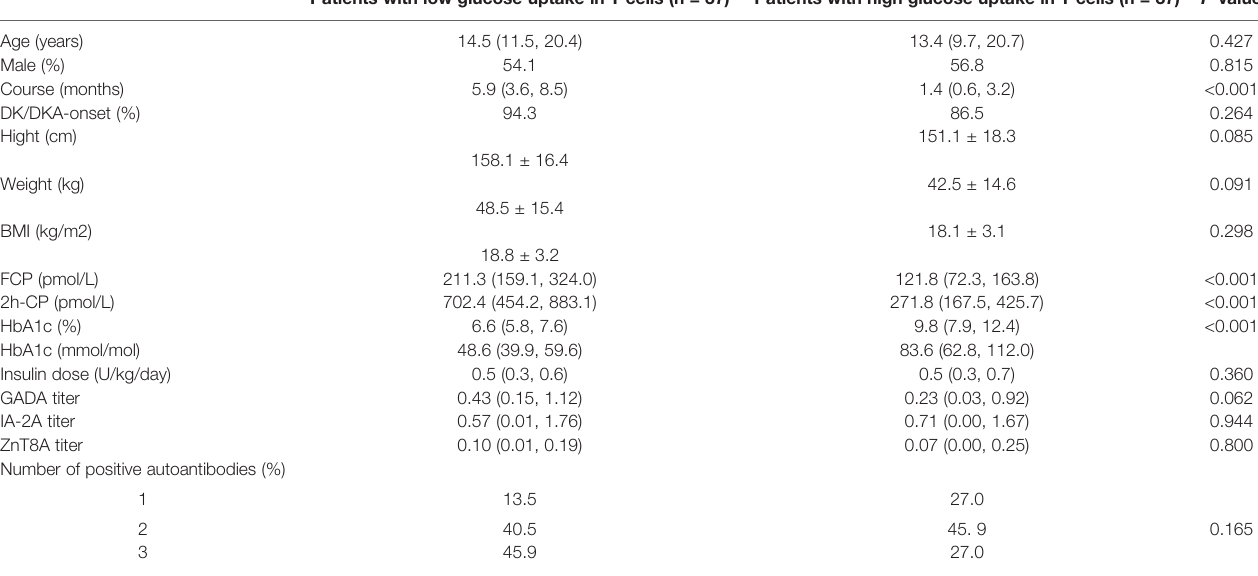
TABLE 3 | Clinical characteristics in T1D patients with different status of glucose uptake in T